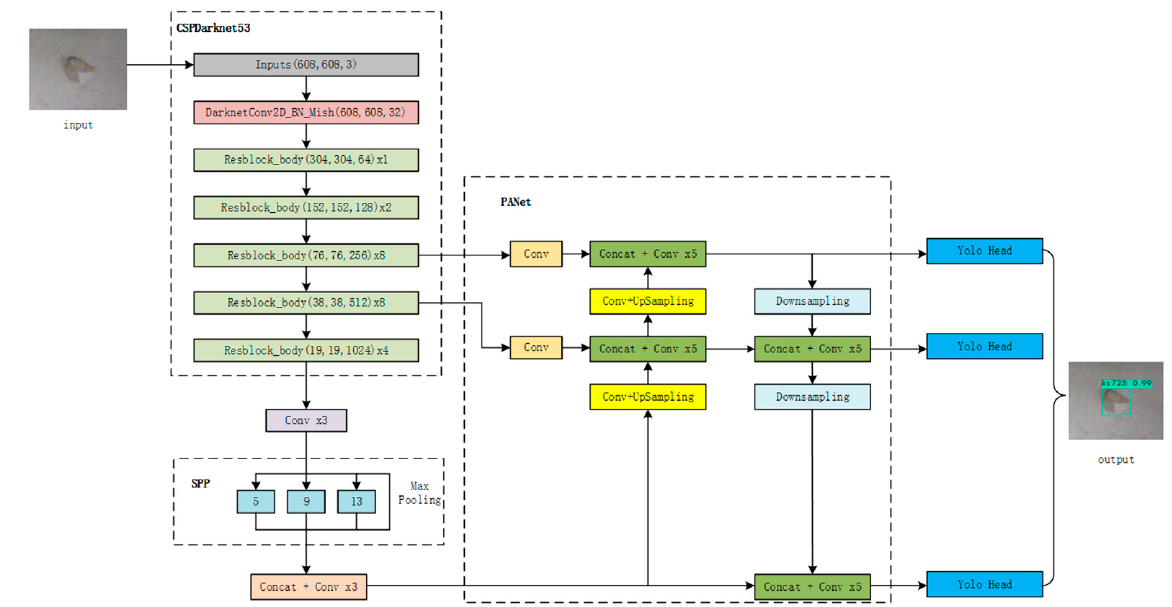
Figure 1. YOLO v4 network structure.